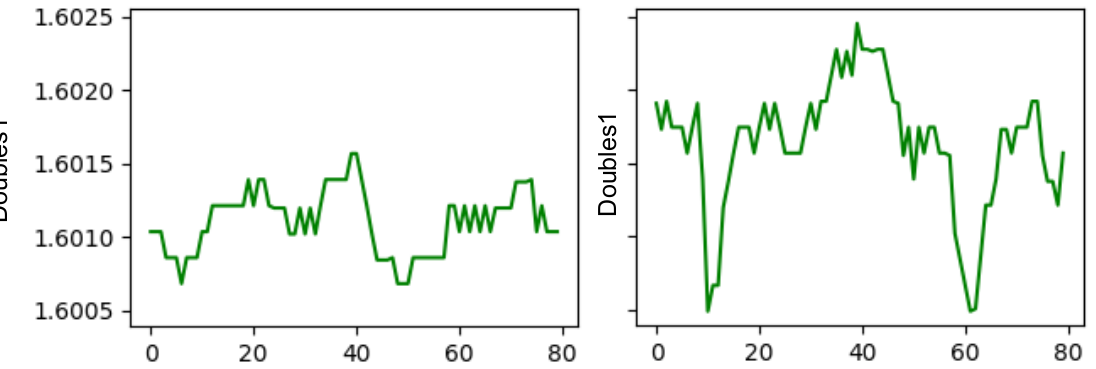
Figure 14. Comparison of the measurements of the transport motor current of a 50€ banknote on reverse front orientation in the case of normal operation ( left ) and that of a failure case ( right ).